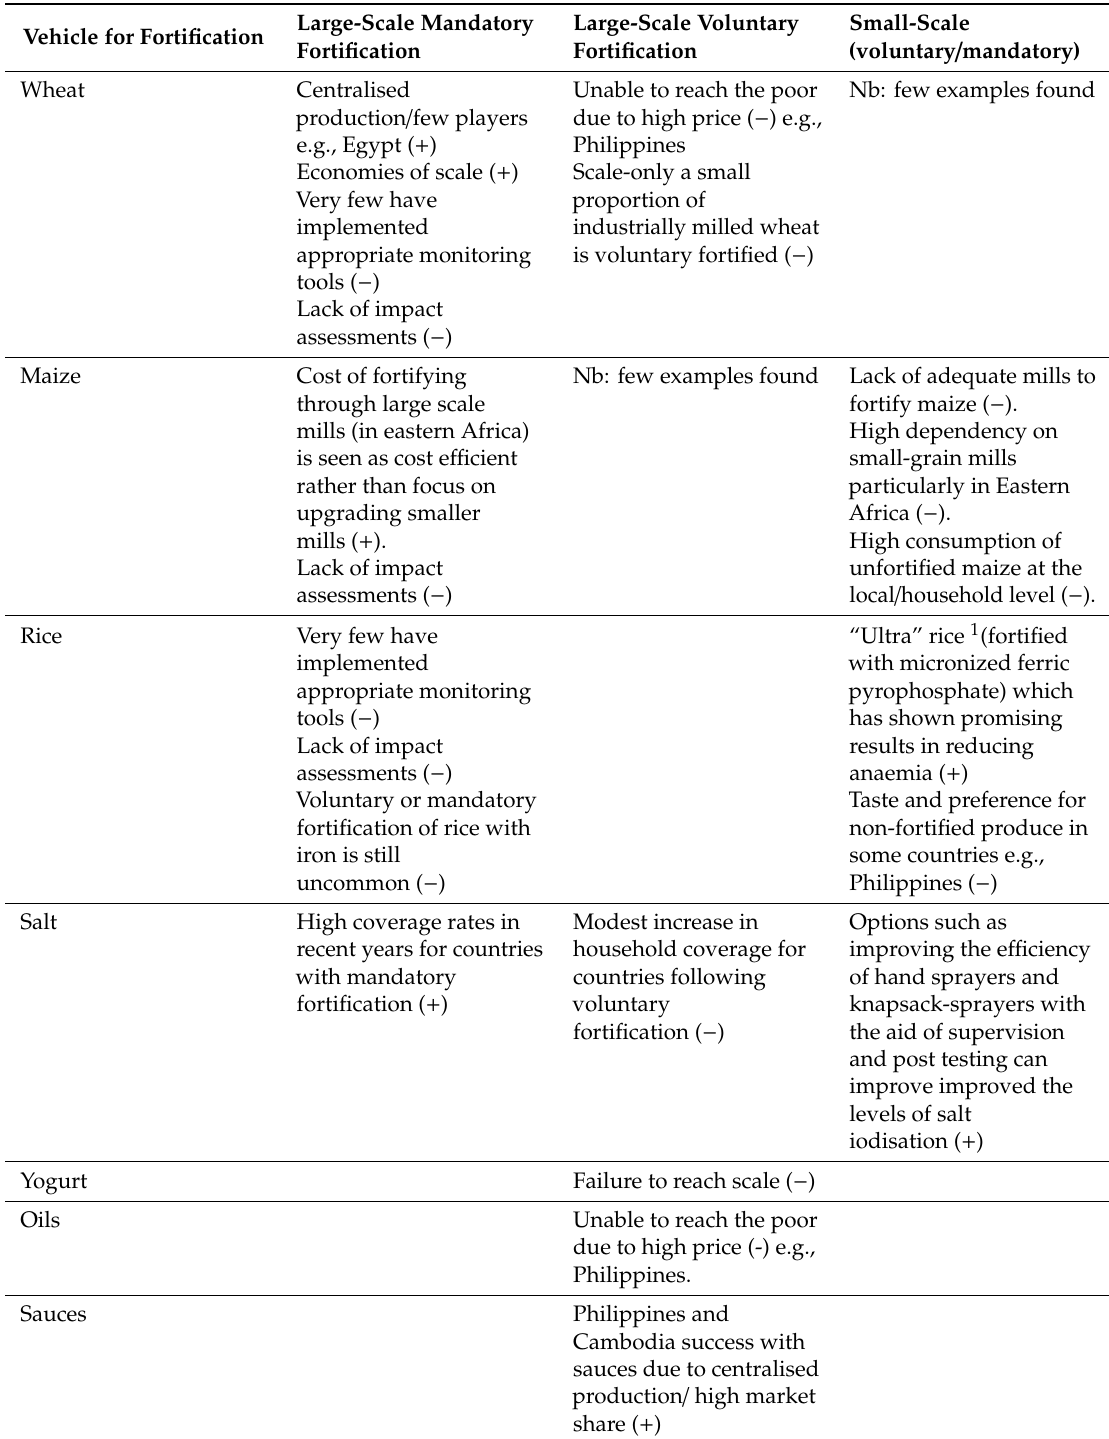
Table 2. Pros ( + ) and cons ( − ) of fortification approaches by vehicle, scale, and legislation. Vehicle for Fortification